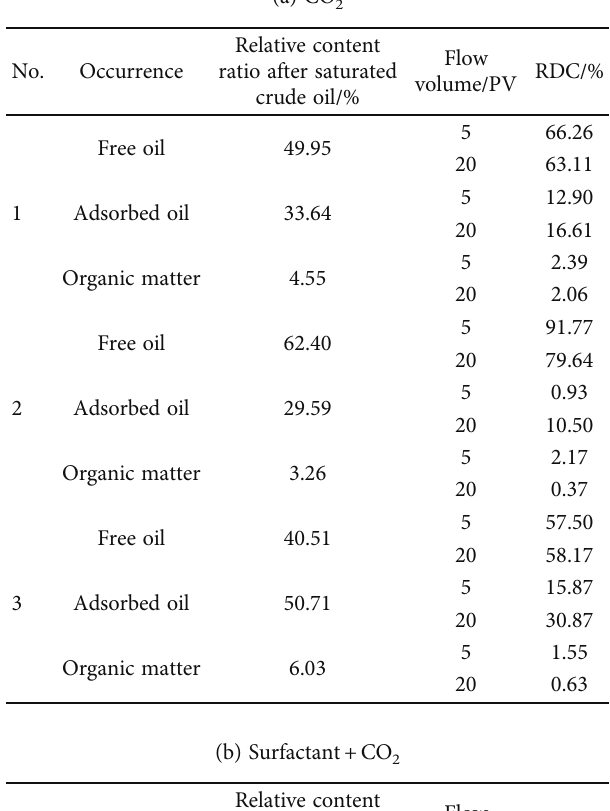
Table 3: Classi fi cation criteria of NMR T di ff erent occurrence states.